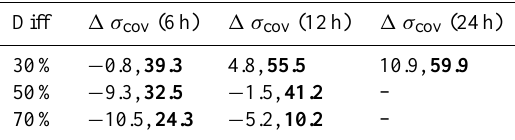
Table A3. Relative difference [%] of mean uncertainty σ(δ) corr , f estimated with the extended two-tower approach and the reference σ cov for EC tower distances >